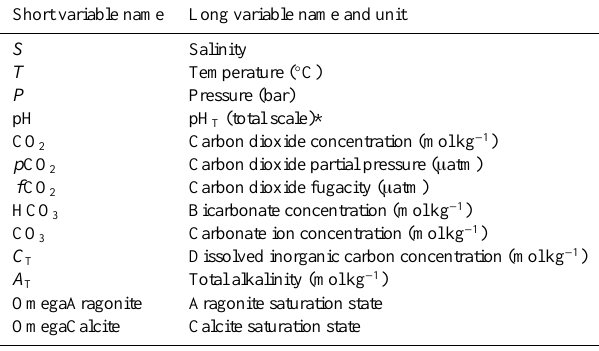
Table 2. R package seacarb (Lavigne and Gattuso, 2010) computes the following carbonate system